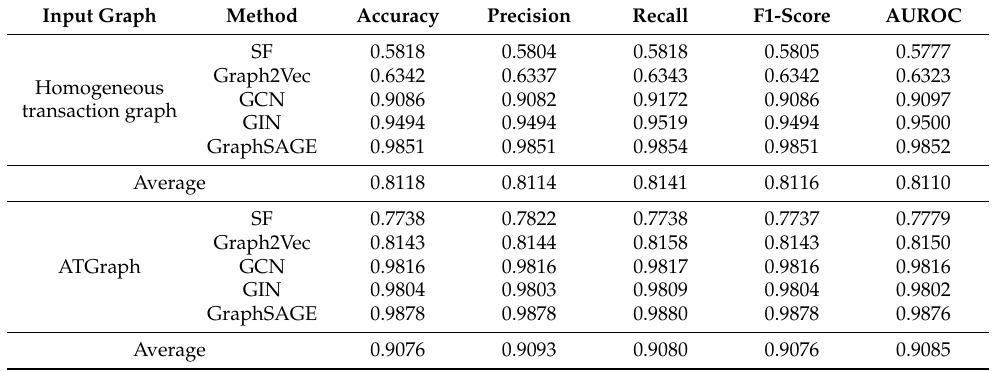
Table 4. Performance comparison using ATGraph and homogeneous transaction graph as input.